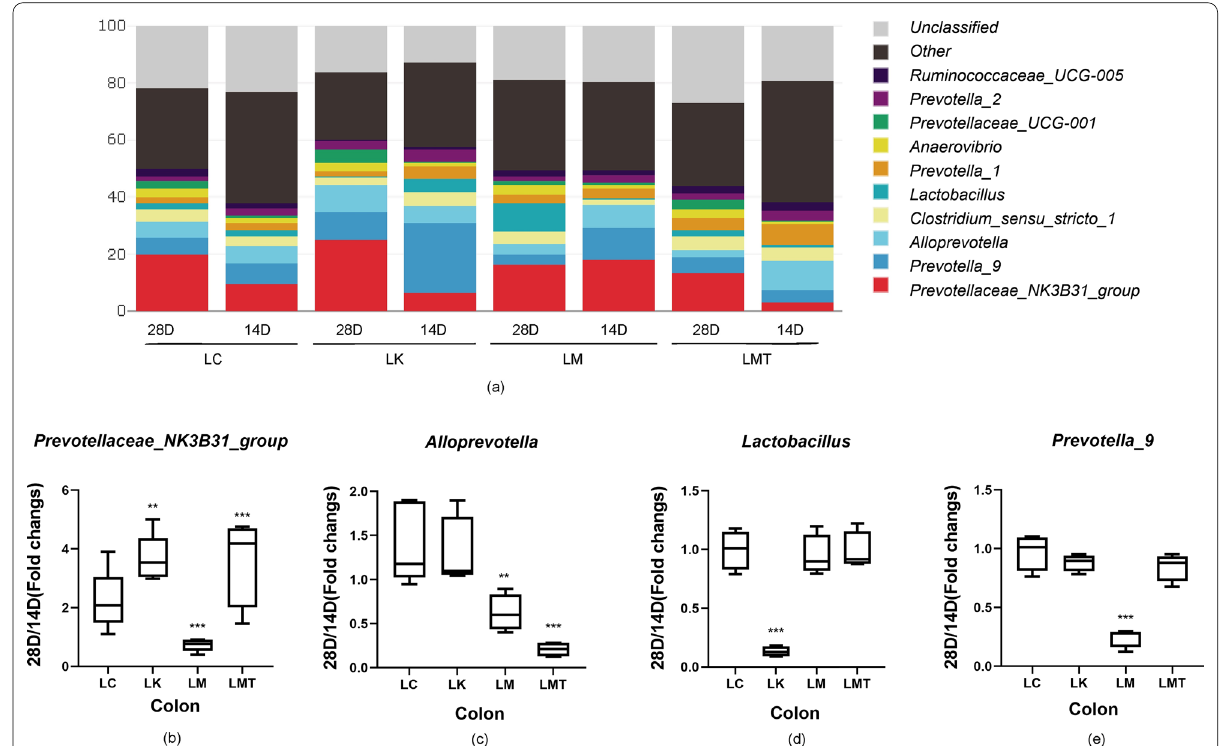
Fig. 6 The composition of colon microbiota at the genus level. a The effect of the TCM formula on the composition of the colon microbiota at the genus level in the weaned piglets. b The fold change in the relative abundance of the genus Prevotellaceae NK3B31 (28 d/14 d ratio). c The fold change in the abundance of the genus Alloprevotella (28 d/14 d ratio). d The fold change in the abundance of the genus Lactobacillus (28 d/14 d ratio). e The fold change in the abundance of the genus Prevotellaceae 9 (28 d/14 d ratio) ( *p < 0.05; **p < 0.02; ***p < 0.01